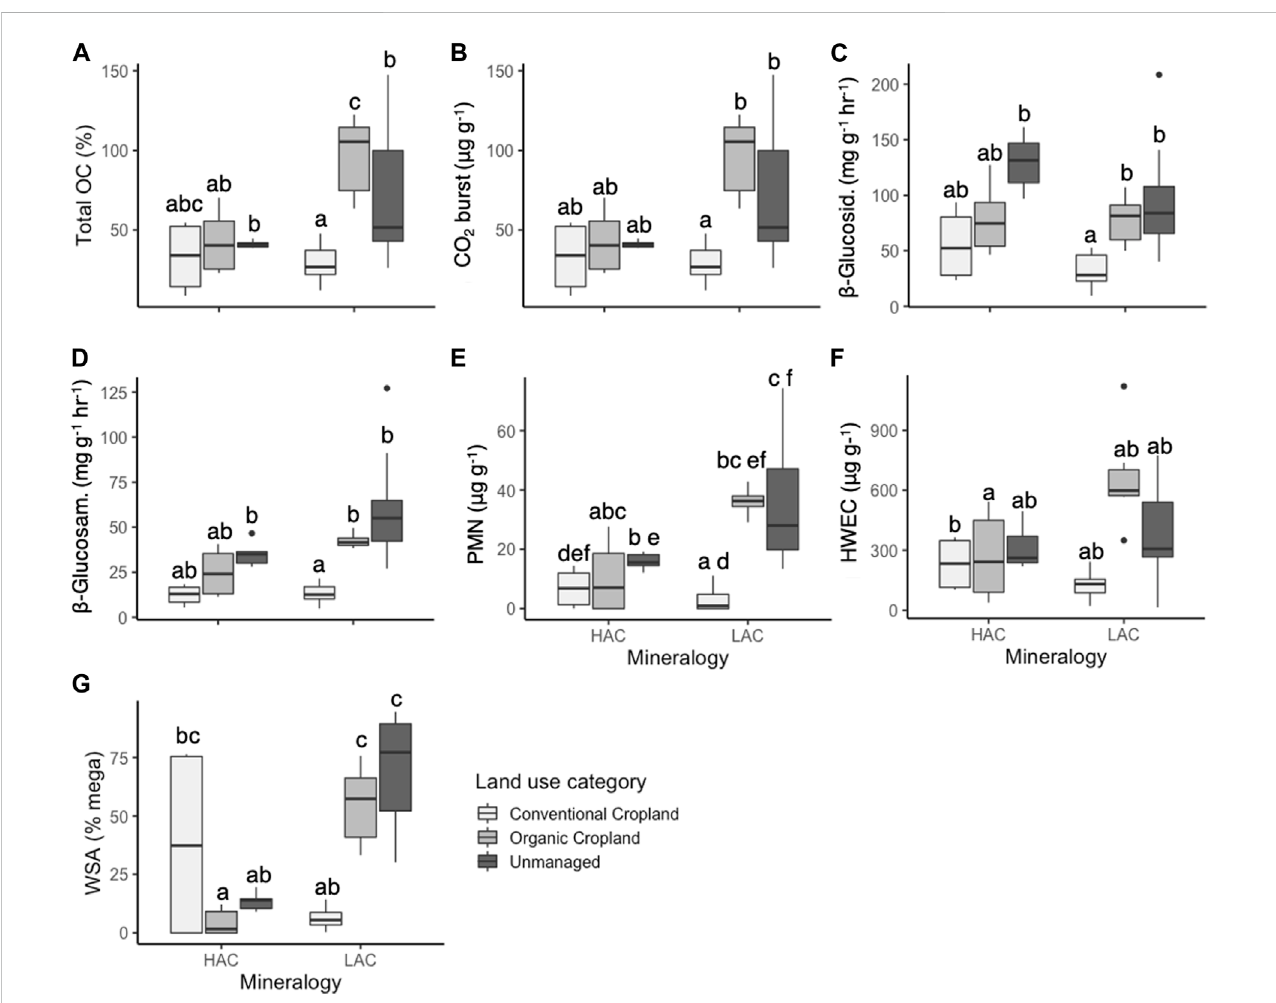
FIGURE 5 Boxplots for the proposed key indicators of health (A – G) for a subset of high (HAC) and low activity clay (LAC) soils under land use classes for conventional cropland, organic cropland, and unmanaged previously intensive agriculture. Means sharing a letter are not signi fi cantly different (Tukey- adjusted comparison of least square means at p-value < .05.) n =